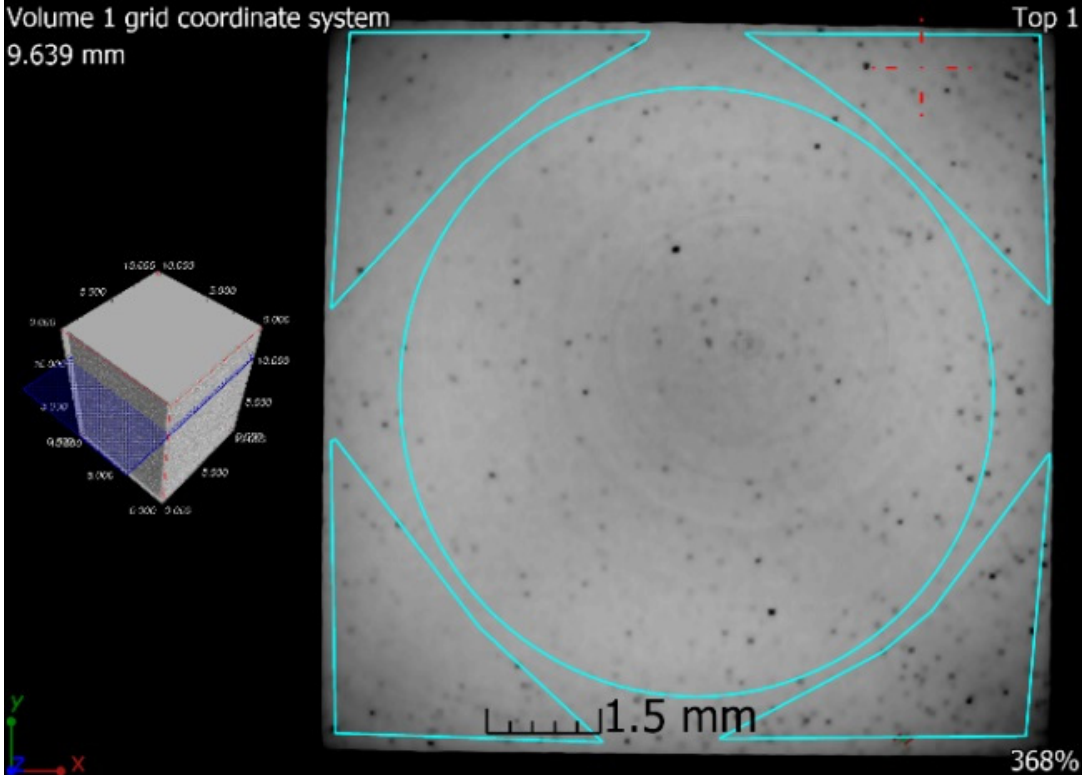
Figure 21. Tomographic CT sections of sample 5 with marked ROIs (regions of interest). Materials 2020 , 13 , x FOR PEER REVIEW